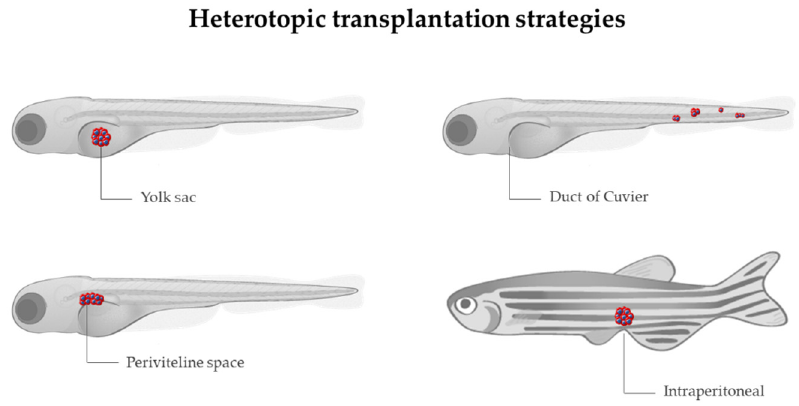
Figure 3. Sites for heterotopic transplantation of tumor cells (in red) in zebrafish. Modified from Servier Medical Art (https://smart.servier.com; accessed on 3 March 2022), licensed by a Creative Commons Attribution 3.0 Unported License, and Lizzy Griffiths.